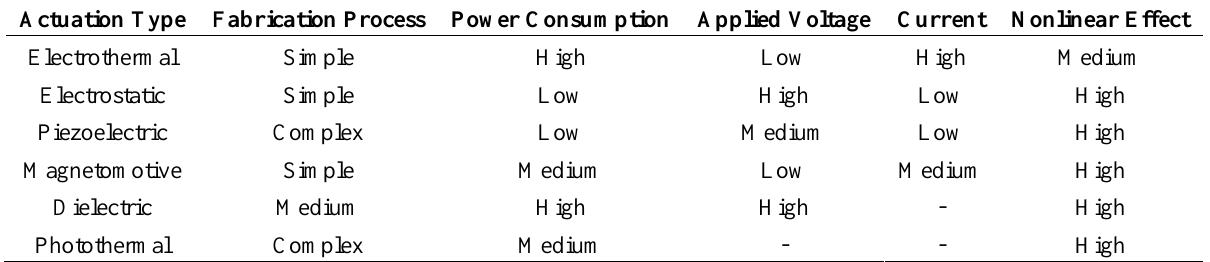
Table 7. Comparison of several actuation mechanisms applied for micro- and nanomechanical resonators. Actuation Type Fabrication Process Electrothermal Electrostatic Simple